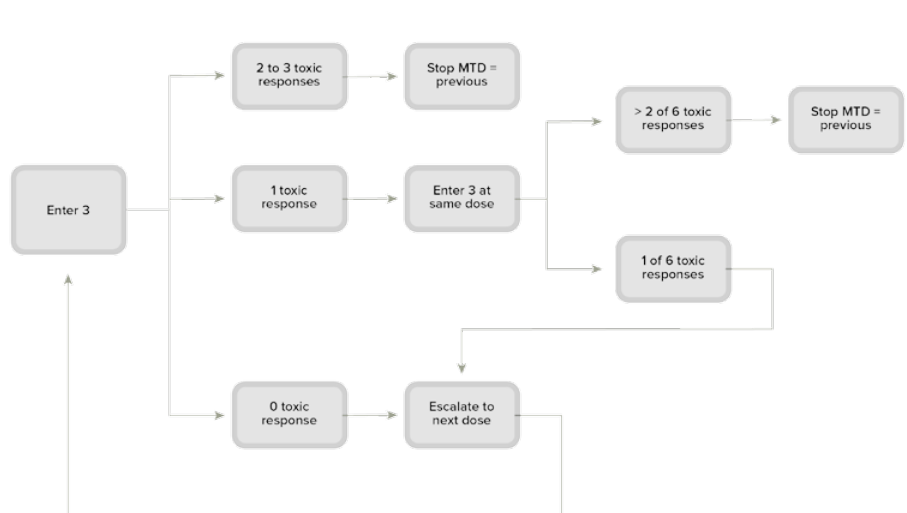
Figure 5. Detailed Flow Diagram of the Accelerated Titration Design. a = Applicable to dose concentration level 1 and 2 only. b = Dose escalation for dose concentration levels 3, 4, 5 will follow the depicted 3 + 3 design only. DLT = dose-limiting toxicity; MTD = maximum tolerated dose; TEAE = treatment-emergent adverse event.